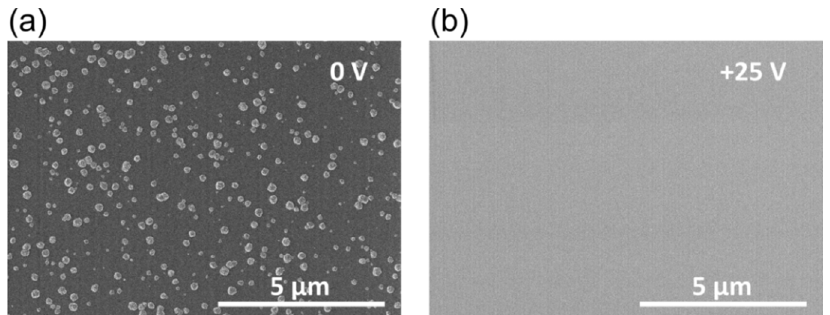
Figure 3. SEM images of TiO 2 layers deposited on Si substrate under the following process conditions: 300 W plasma power; 100 °C substrate temperature; 10 sccm oxygen gas flow corresponding to 5.7 Pa chamber pressure and DC BIAS ( a ) 0 V; and ( b ) +25 V.